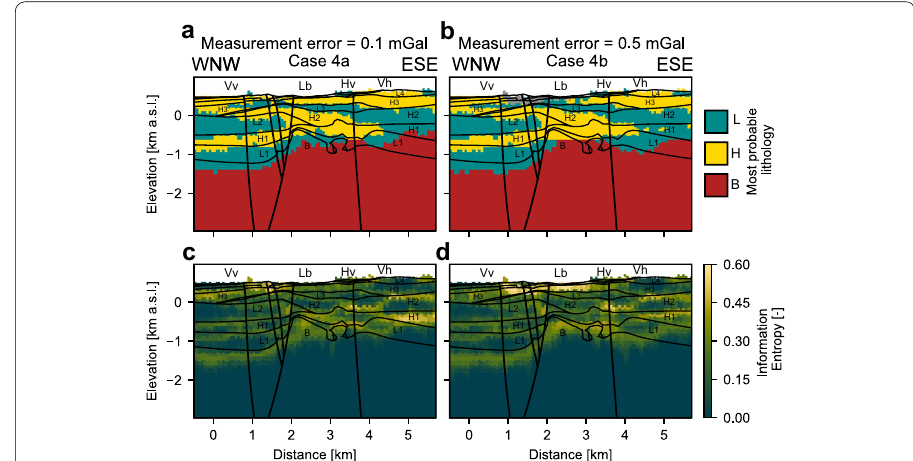
Fig. 13 Effect of strength of assumed measurement error on uncertainty of posterior results (Case 4). Posterior results for ( a – b ) most probable lithology and ( c – d ) information entropy, for inversion runs with assumed measurement error of ( a , b ) 0.1 mGal (Case 4a) or ( b , d ) 0.5 mGal (Case 4b), for inversions also assuming a moderate commonality constraint and rougher shape ratio constraint. Results are shown along Section